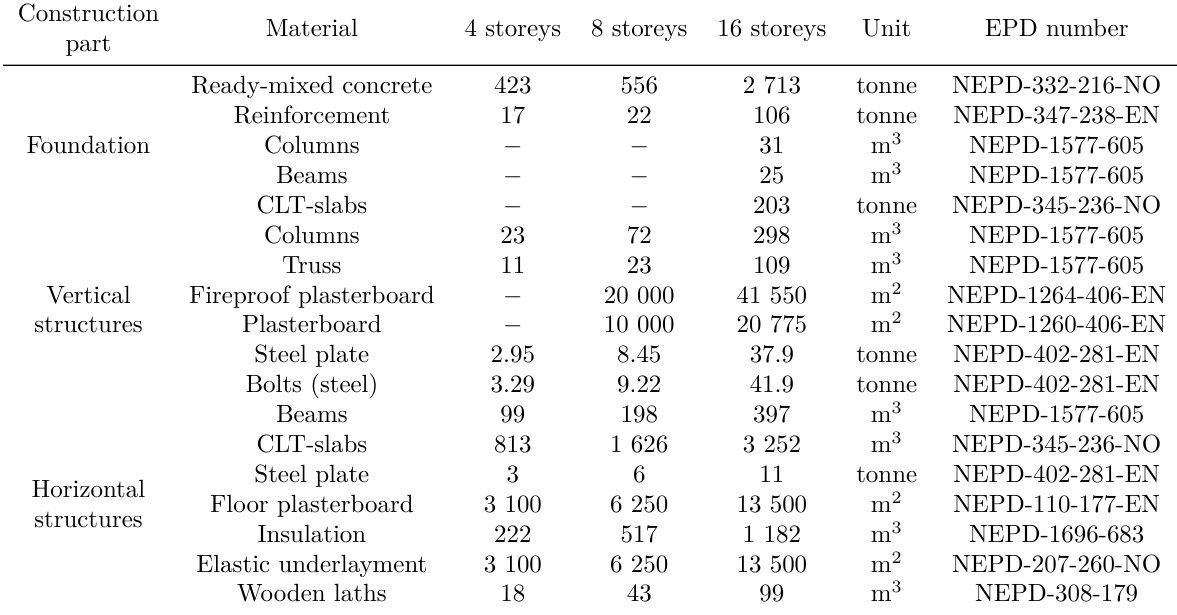
Table 1. Material amounts for the CLT-based load-bearing structure.